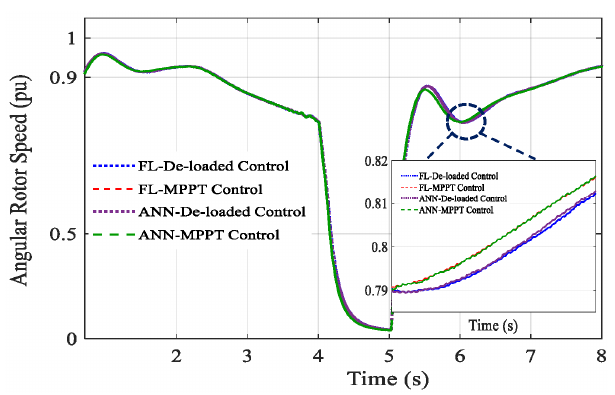
Figure 11. Angular rotor speed at the time of the grid-voltage sag.